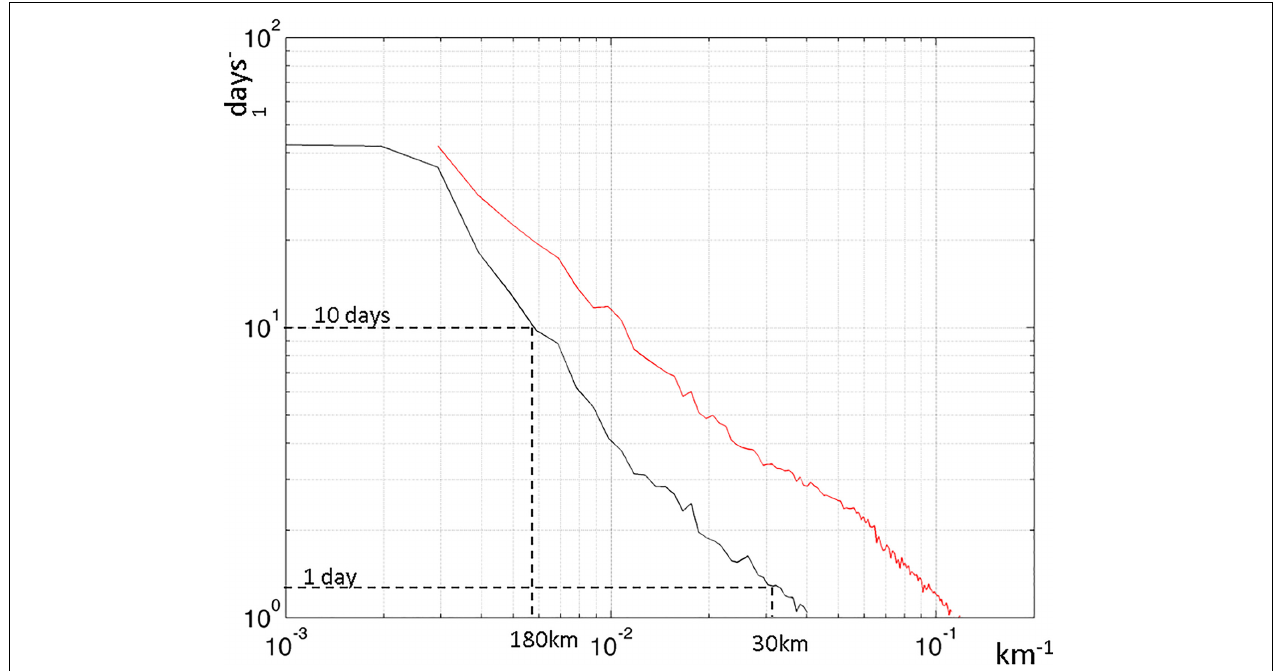
FIGURE 8 | Black curve: decorrelation time as a function of wavelength (shown in inverse log scale, per day and/km, respectively) estimated from an MITgcm simulation in the North Atlantic. Red curve: Decorrelation time when we subtract the 1-layer Quasi-Geostrophic evolution ( Credits: NASA-JPL ).